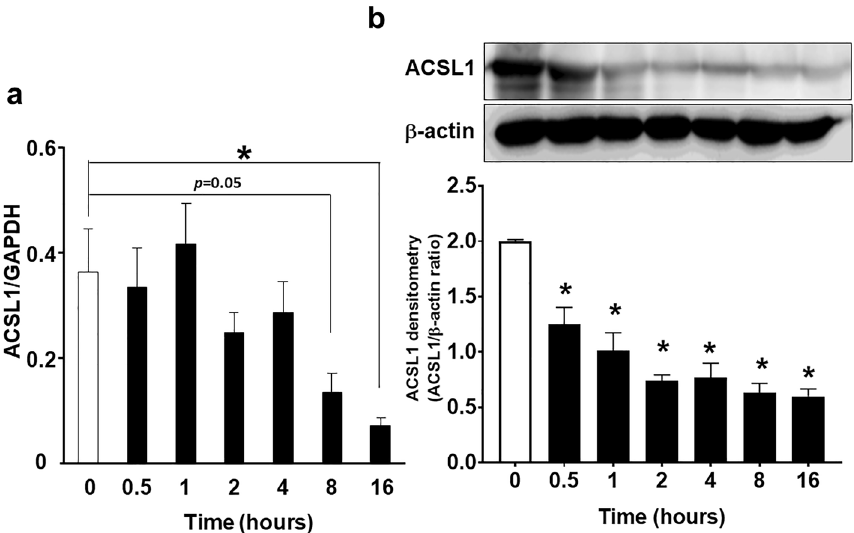
Figure 2. Cinnamon extract (CE) regulates Acyl-CoA synthetase long-chain family 1 (ACSL1) mRNA and protein expression in a time-dependent manner in 3T3-L1 adipocytes. 3T3-L1 adipocytes were serum-starved for 8 h in DMEM and then treated with 30 μg/mL of CE for 0.5–16 h. ( a ) Real-time PCR was employed to determine ACSL1 mRNA expression. ( b ) The levels of ACSL1 protein expression were measured via western blotting. The image is a cropped blot and the full-length images of the western blot for the three experiments are provided in Supplementary Fig. S2a. Each value represents the mean ± SD of three different experiments (n = 3/ group). * p < 0.05, compared with the control